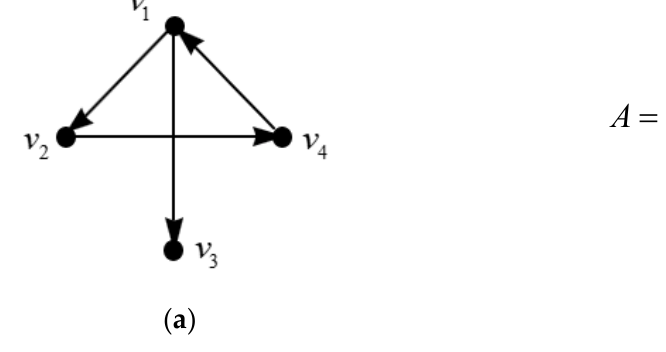
Figure 6. ( a ) A directed graph; ( b ) Its adjacency matrix.